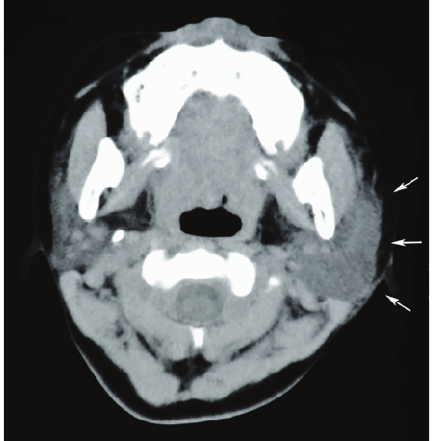
Figure 2: A computed tomography image of the neck reveals the swelling of the left parotid gland